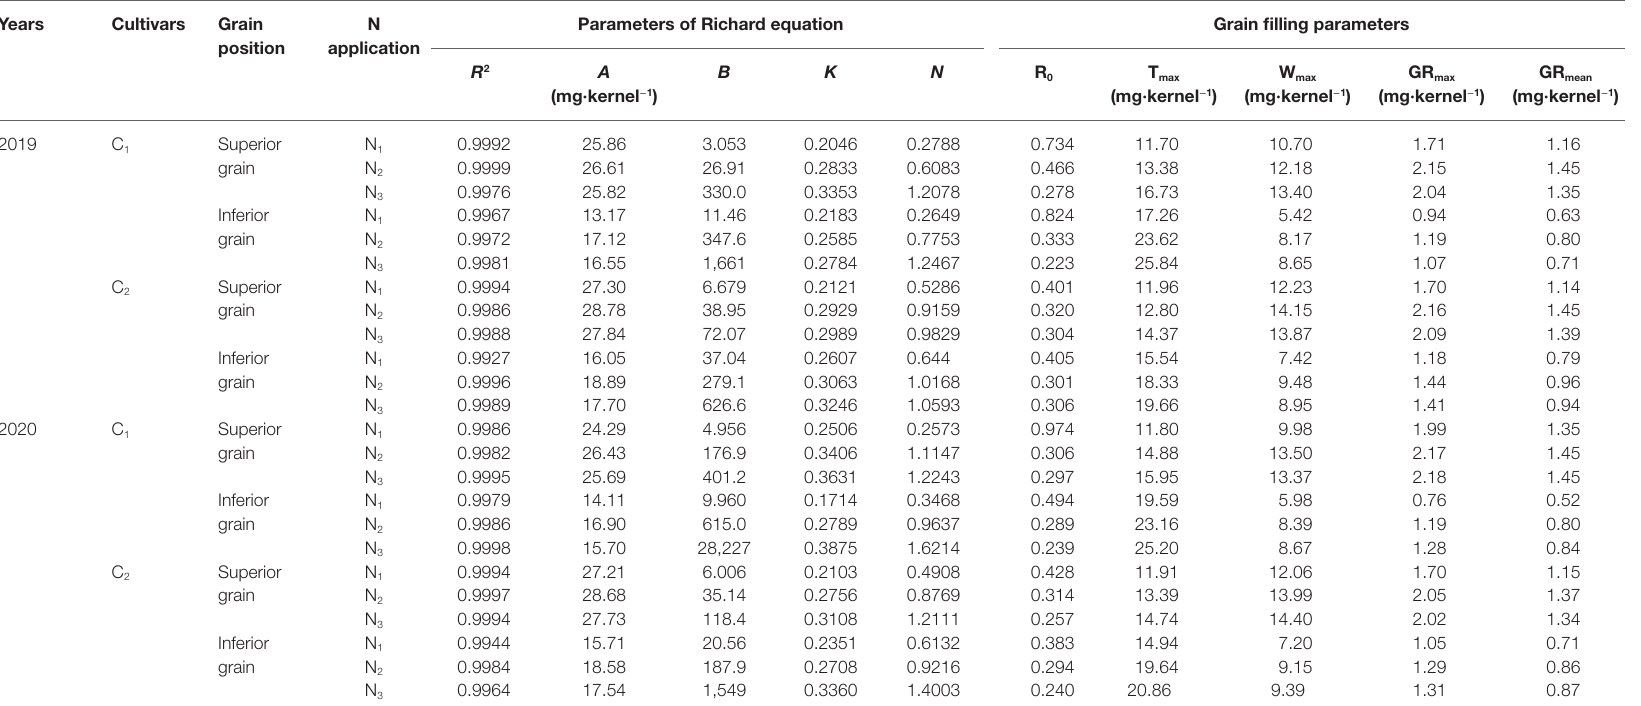
TABLE 2 | Effects of nitrogen application rate on parameters of Richard equation and grain filling